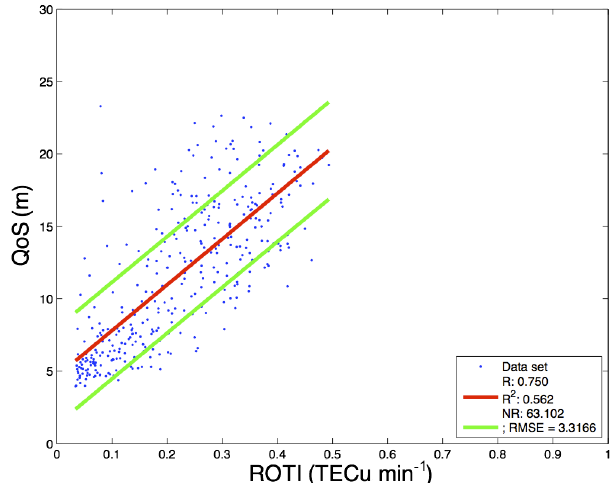
Figure 8. Interrelationship of ionospheric plasma irregularities and SBAS performance for the whole year (1 January–31 December)